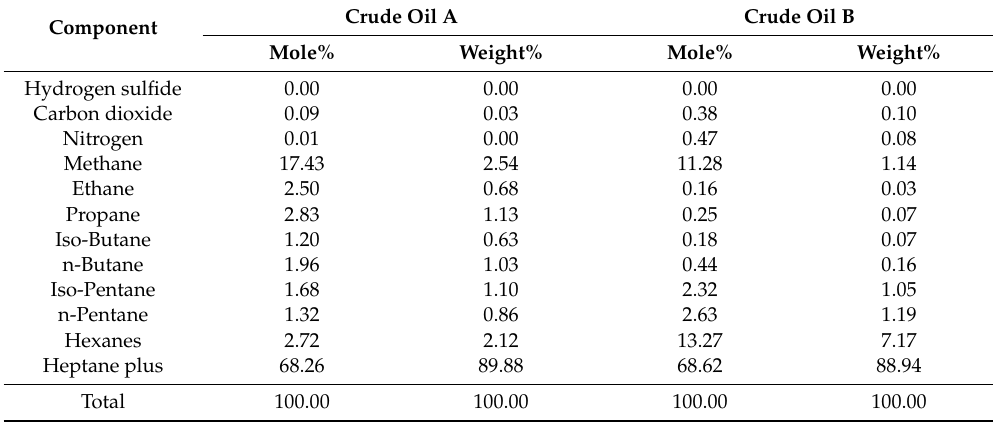
Figure 1. A target reservoir planned CO 2 flooding at the South Sumatra basin, Indonesia. 94 Table 1. Hydrocarbon composition of crude oil samples A and B. 95